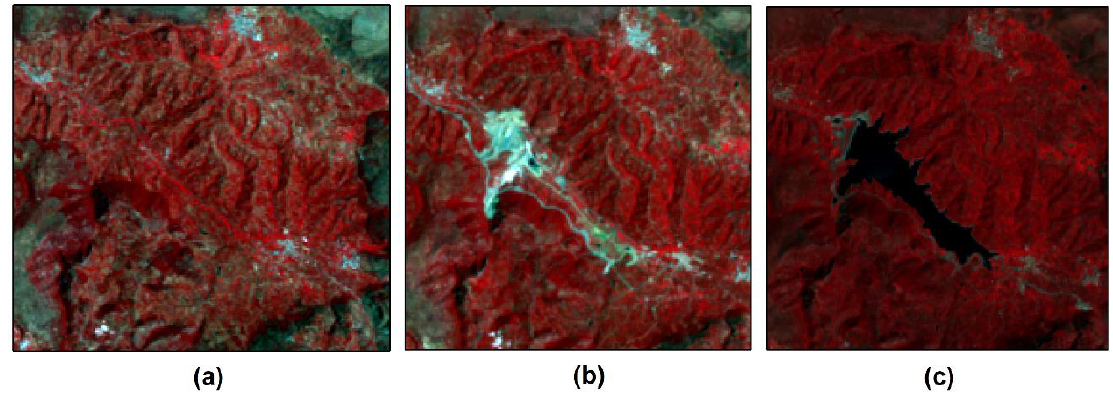
Figure 11. Multi-temporal Landsat color-infrared images focused on Aposelemis dam: ( a ) 1999; ( b ) 2009; ( c ) 2019.